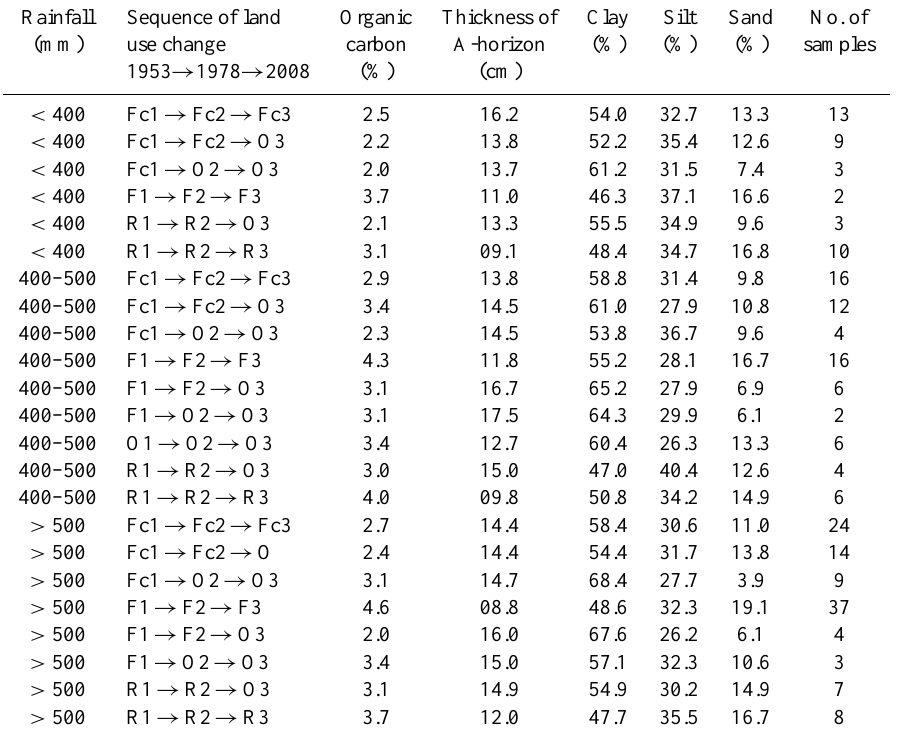
Table 6. Distribution of soil properties and sequence of land use change, by rainfall zones. Rainfall